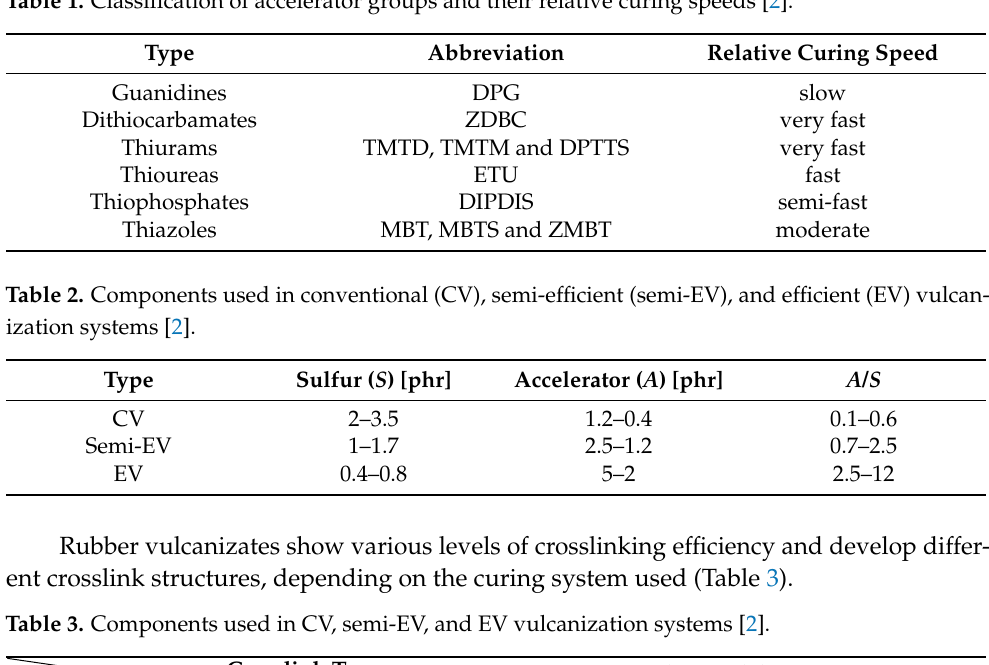
Table 1. Classification of accelerator groups and their relative curing speeds [2].